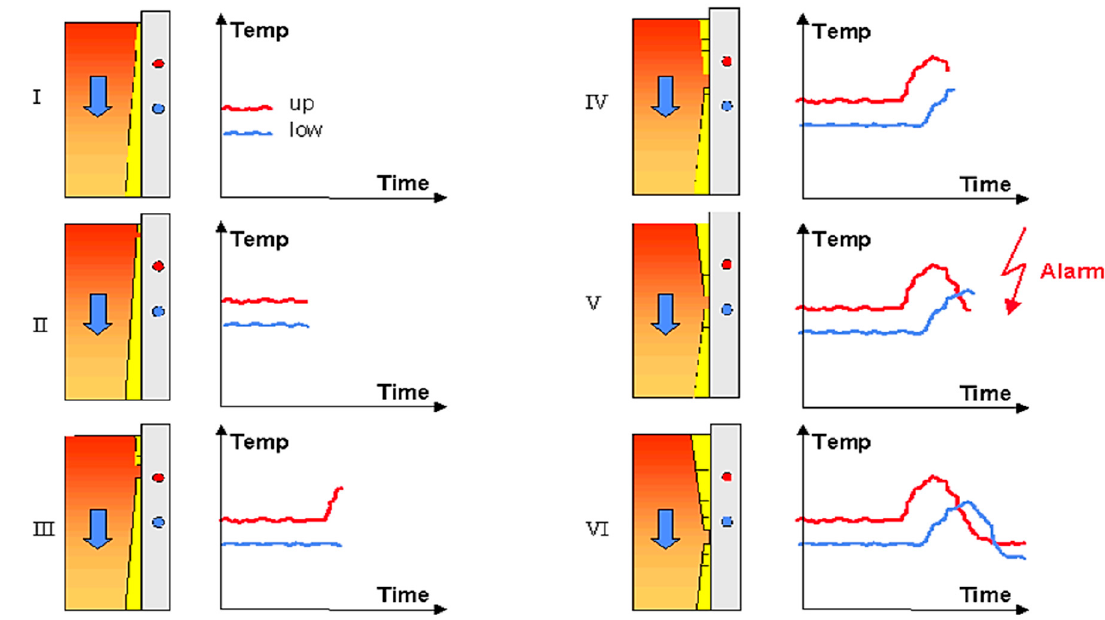
Figure 4. Sticker development temperature variation in sensors.